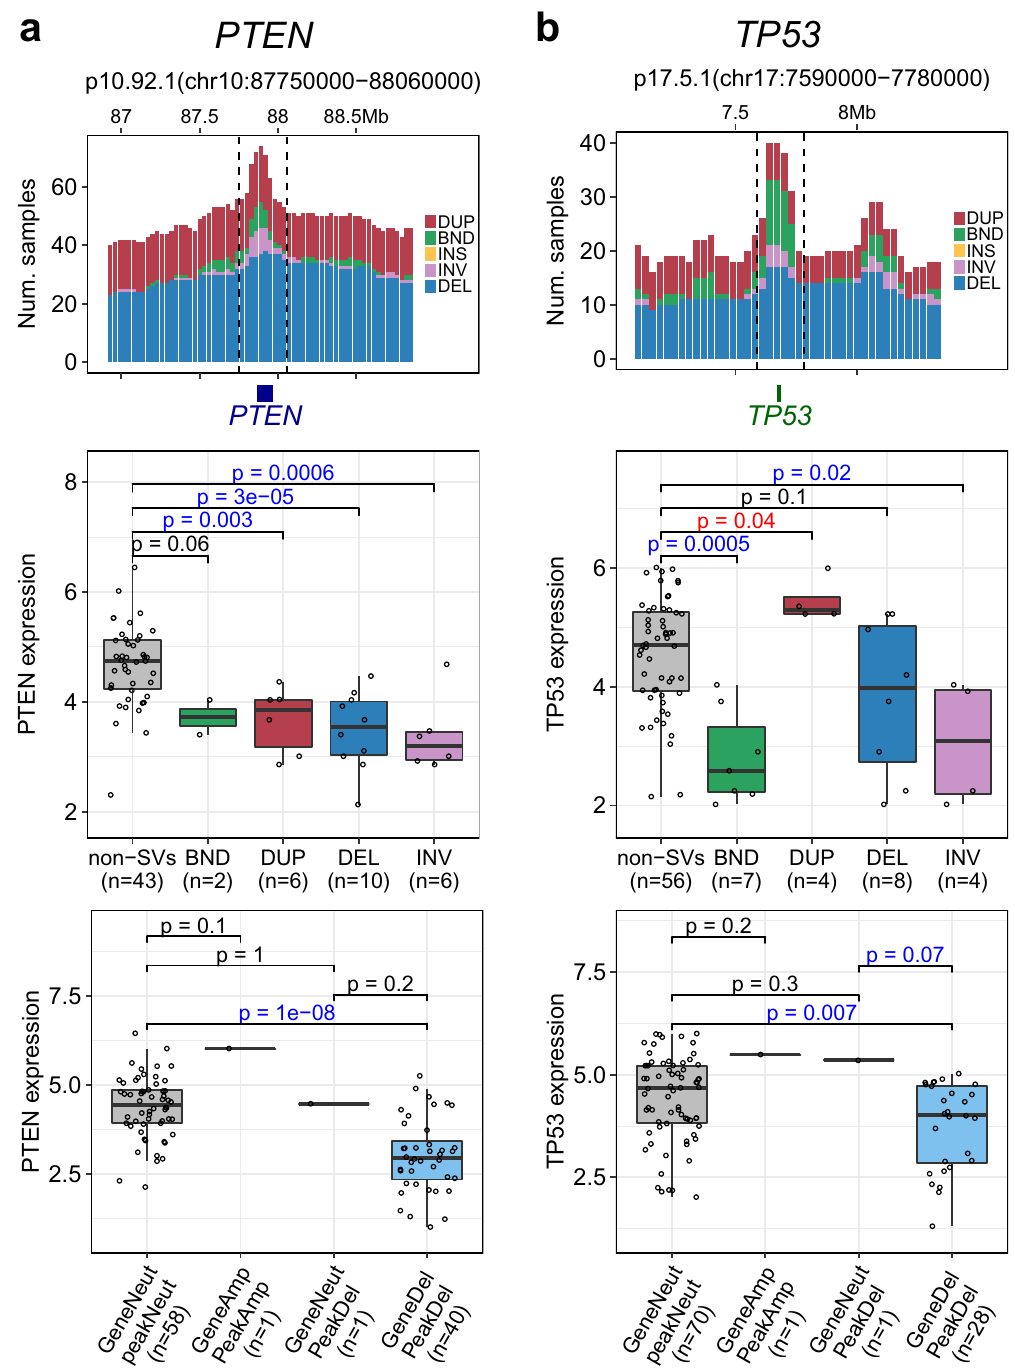
Figure 6. SV-HotSpot identifies hotspots of SVs disrupting tumor suppressor genes PTEN and TP53 . ( a ) Hotspot of SVs targeting PTEN locus. From top to bottom are stack histogram of sample counts for different SV types within the peak region (bounded by dashed black lines), comparison of PTEN expression between SV types in patients whose PTEN is copy neutral, and comparison of PTEN expression between samples whose peak/gene are copy neutral/loss. ( b ) Hotspot of SVs targeting TP53 locus. As shown, PTEN expression is significantly decreased in the presence of deletion, duplication, translocation, or inversion while TP53 expression is significantly decreased in the presence of translocation or inversion. Both genes show significantly decreased expression when affected by copy number